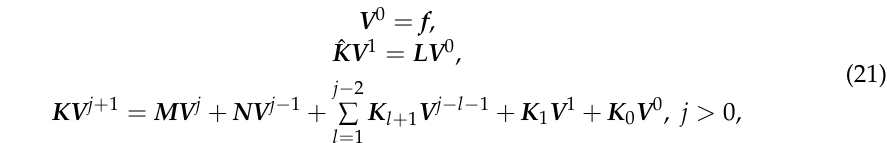
Figure 2. Effect of 𝜇 = 𝛼 = 𝛽 and ( a ) Gr when 𝝀 𝟏𝜶 =Λ 1 = 0.5, Pr = 15, 𝝀 𝟐𝜷 =Λ 2 = 0.7, ϕ = 0.01 ( b ) 𝝀 𝟏𝜶 =Λ 1 when Gr = 5, Pr = 15, 𝝀 𝟐𝜷 = Λ 2 = 0.7, ϕ = 0.01 on the velocity profiles.